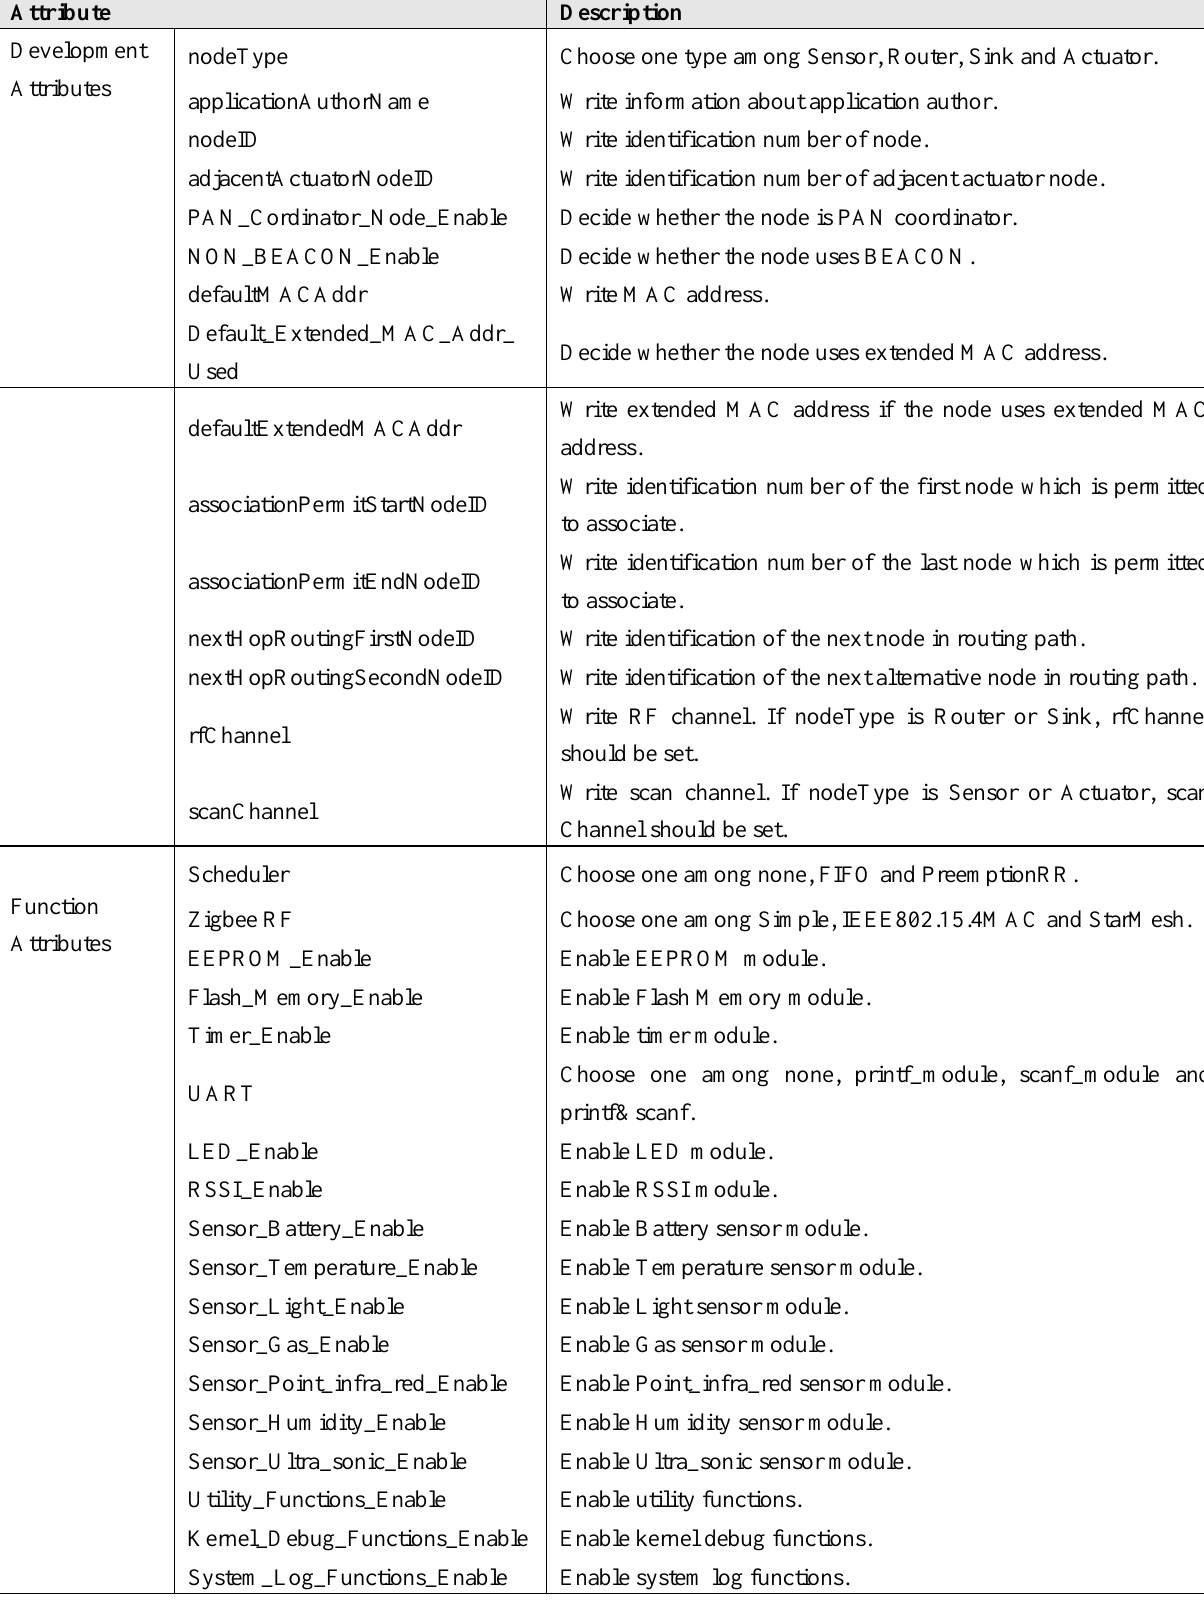
Table 2. The list of attribues for the design of node software based on Nano-Qplus. Attribute Description